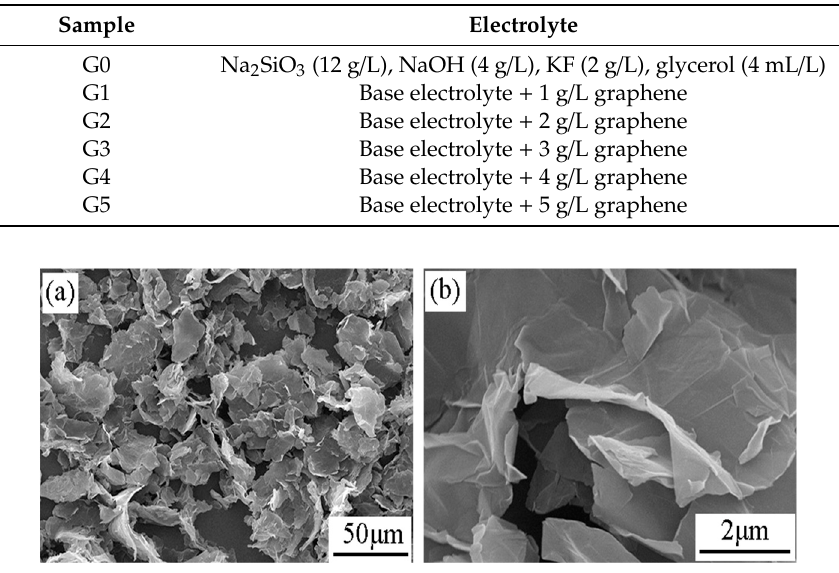
Figure 1. Different magnification of the scanning electron microscope (SEM ) images of graphene: ( a ) Figure 1. Di ff erent magnification of the scanning electron microscope (SEM) images of graphene: 1000× ( b ) 30000×. ( a ) 1000 × ( b ) 30000 ×